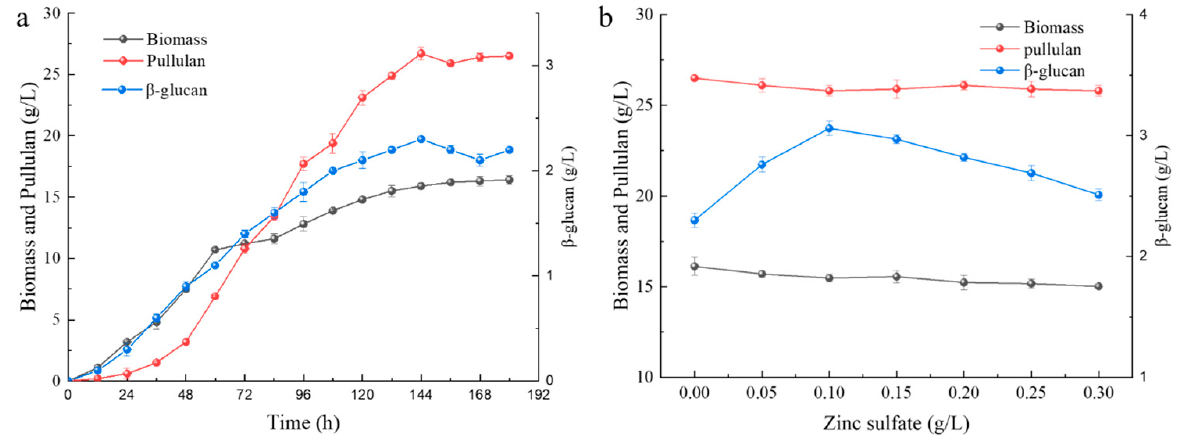
Figure 1. Effects of fermentation time ( a ) and ZnSO4 additive amount ( b ) on A. pullulans ’s biomass, pullulan yield, and β -glucan yield.